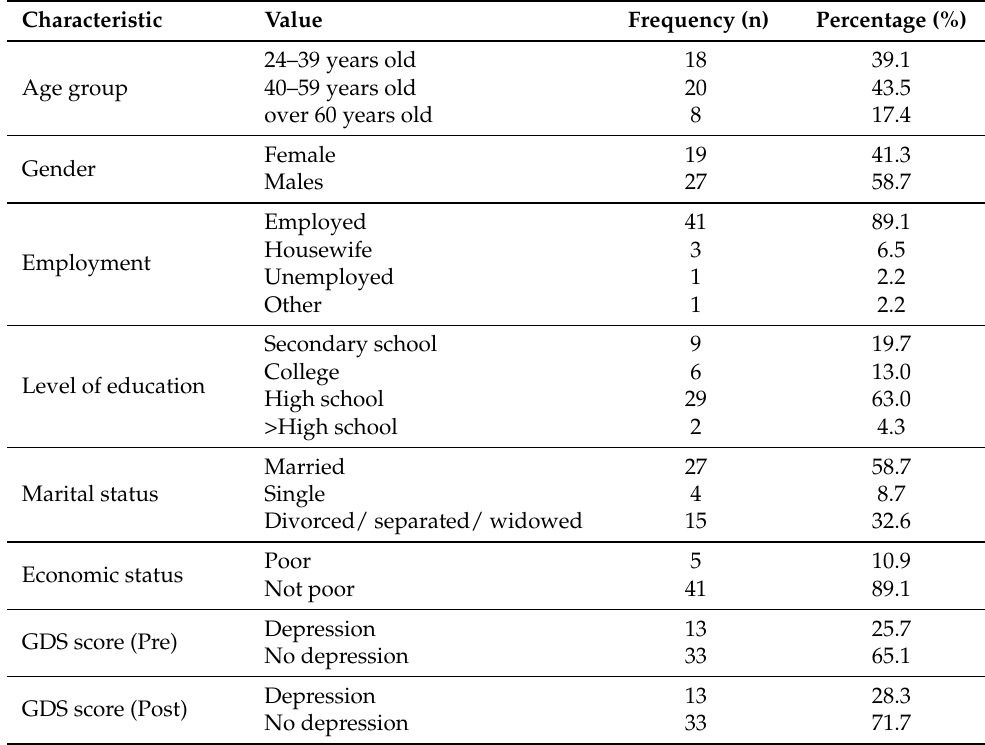
Table 2. Study population characteristics ( n =